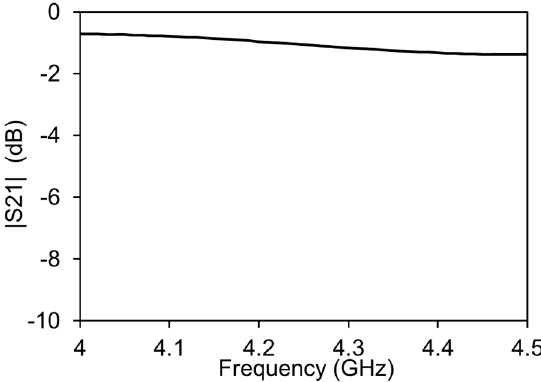
Figure 3. FEM s imulations of the IDC without the attenuator and phase shifter. Figure 3. FEM simulations of the IDC without the attenuator and phase shifter.